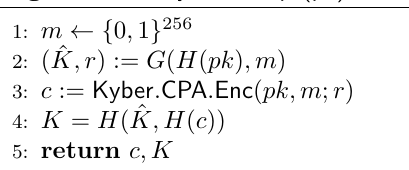
Algorithm 7 Kyber . Decaps ( sk = ( s , z, t , ρ ) , c